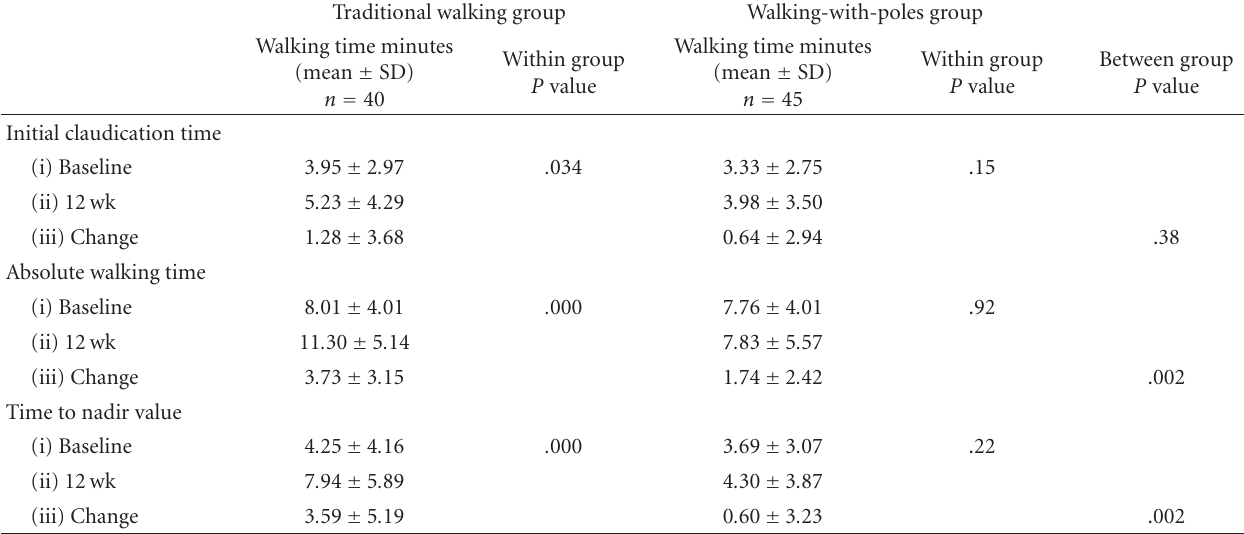
Table 3: Exercise times at baseline and 12 weeks, intent-to-treat analysis ( n = 85). Traditional walking group Walking-with-poles group Walking time minutes